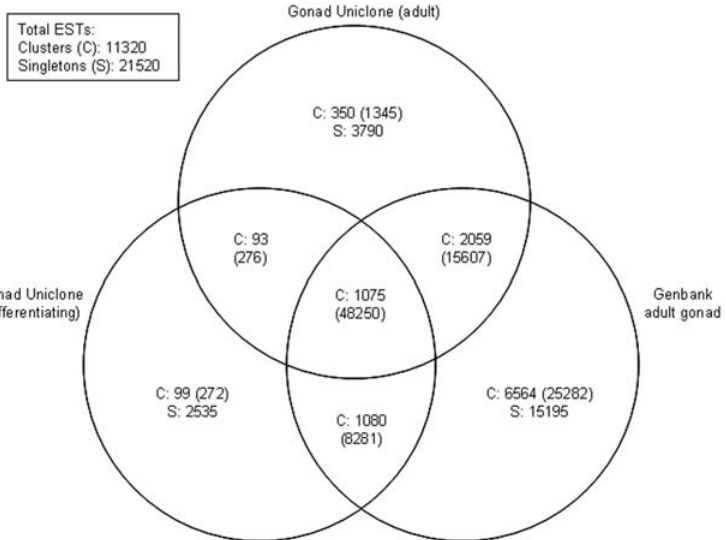
Figure 1. Venn diagram depicting the clones used for insilico normalization for the generation of the Gonad Uniclone Microarray. The number of adult and differentiating gonad-derived zebrafish sequences present in our Gonad Uniclone EST collection and their extent of overlap with gonad-derived public zebrafish ESTs listed in GenBank are shown. For details on sequence pre-processing and clustering, refer to the Methods section. In overlapping sections, the total number of clusters, prefaced by ‘C’, is followed in parentheses by the total number of ESTs contained by the clusters. The total number of singletons is prefaced by ‘S’.